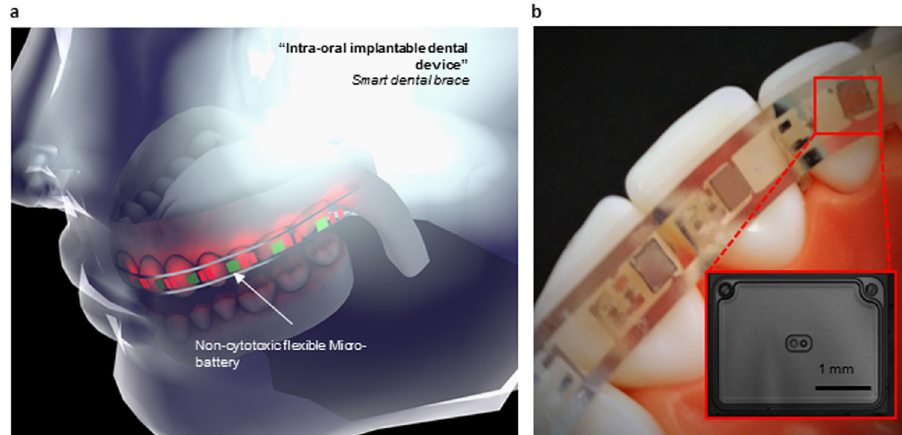
Fig. 1 Flexible, non-cytotoxic battery concept. a Non-cytotoxic fl exible battery is a key enabler for an integrated intra-oral phototherapeutic device that fi ts in conformable manner onto the human dental arch. b Optical images of an intra-oral implantable device that relies on millimeter-sized fl exible, biocompatible lithium-ion battery as a rapid powering